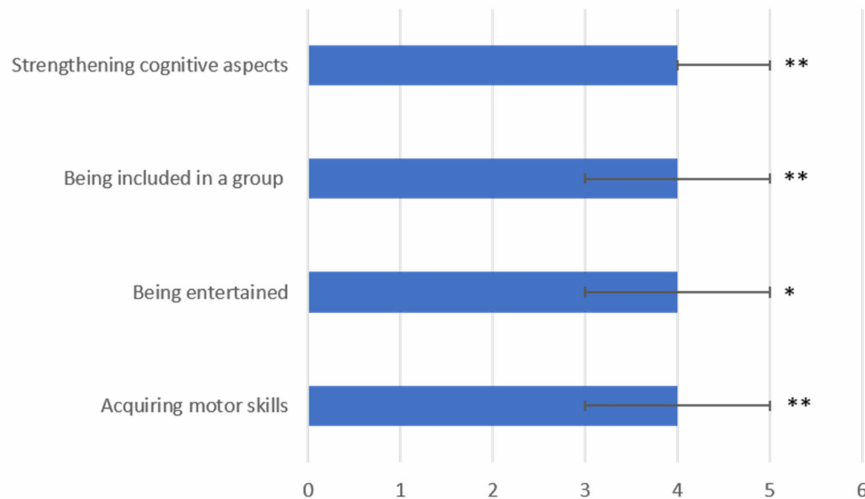
Figure 5. Relevance of the technology in acquiring motor skills, entertaining, being included